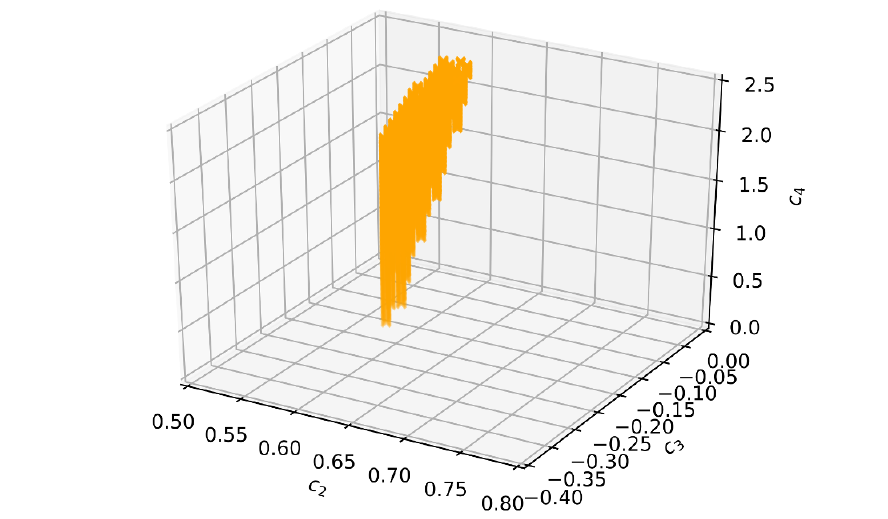
Figure 1. Numerical scan over (cid:0) 10 (cid:20) c i (cid:20) 10 for i = 2 ; 3 ; 4, taking c 1 = (cid:0) 1 : 0 and with step size (cid:1) c = 0 : 01. Points which satisfy all inequalities in the \summary of constraints" are labelled by an orange (cid:2) .